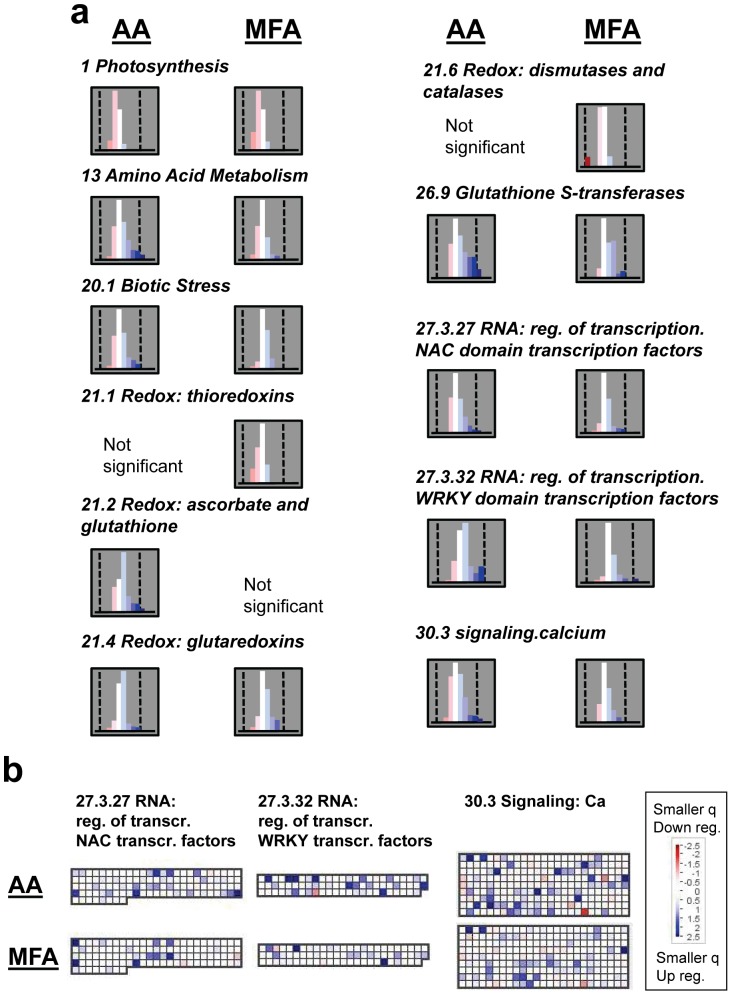
Selected functional gene categories (BINs) generated by MapMan analysis.The q-value data sets, adjusted for transcript directional change, from cytochrome pathway inhibition by AA and TCA cycle inhibition by MFA treatment were used. Red shading indicates genes whose transcript level decreased from treatment; blue shading indicates those whose level increased. a, Gene frequency histograms. The central, white bar of each histogram represents genes with poor statistical significance. The vertical dashed lines are at −2.5 and 2.5 for each histogram. Values less than −2.5 or greater than 2.5 indicate q = 0.0032 or less. Note that the total number of genes in each BIN varies. BIN gene numbers: 1 = 157; 13 = 350; 20.1 = 469; 21.1 = 67; 21.2 = 56; 21.4 = 41; 21.6 = 14; 26.9 = 51; 27.3.27 = 108; 27.3.32 = 74; 30.3 = 225. b, Diagrams from MapMan showing signaling-related functional categories. The logged q-value is shown for each gene (a small square). The correlation between color and intensity and the q-value is shown by the scale. Color scale saturates at 2.5; values less than −1.3 or greater than 1.3 correspond to q-values of 0.05 or less.